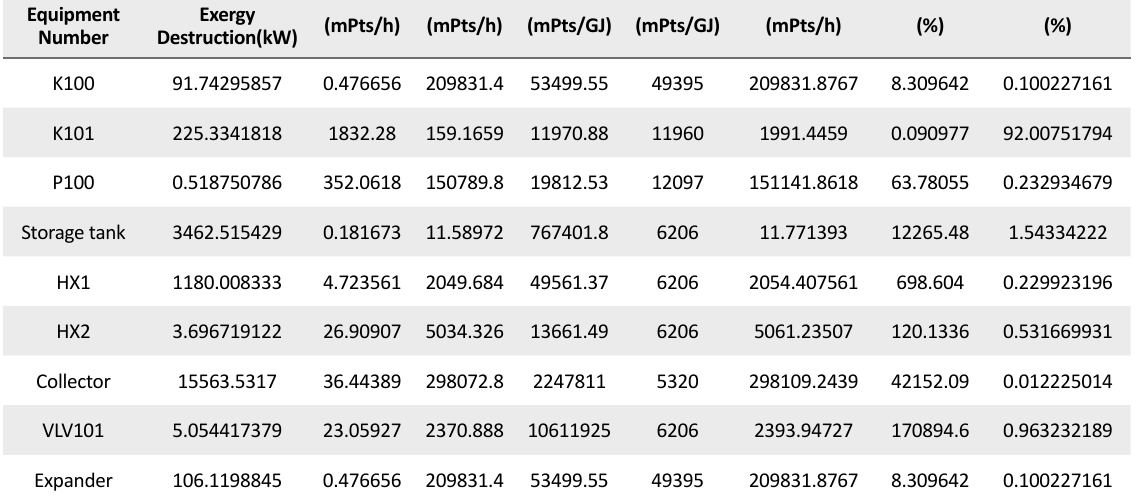
Table 12. Results of system ecological